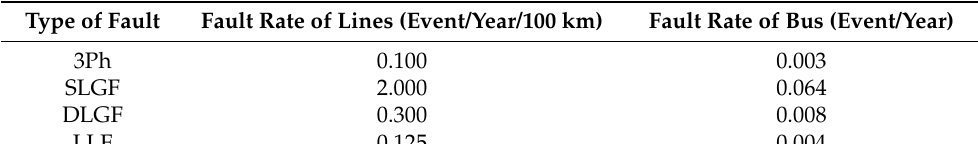
Figure 10. Distribution network of the district of Haridwar.